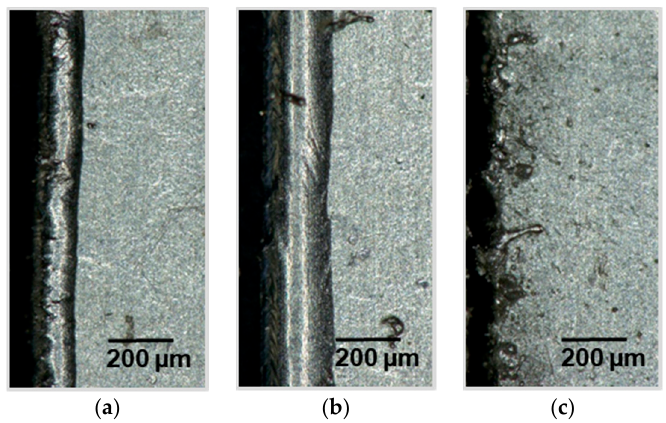
Figure 9. Light microscope sections of a laser cut lithium sheet: 72.8 W, 200 kHz, 240 ns; ( a ) 50 mm/s, PO 99.72%; ( b ) 75 mm/s, PO 99.58%; ( c ) 100 mm/s, PO 99.44%.